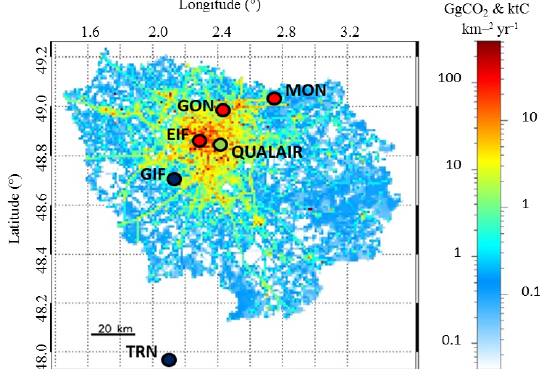
Figure 1. Annual emissions of CO 2 from Île-de-France at a spatial resolution of 1 × 1km 2 (AIRPARIF, 2010) and our Paris megacity CO 2 in situ network: the red points indicate the CO 2 -MegaParis stations (MON is a NE rural site at 9ma.g.l.; GON is a NE peri- urban site at 4ma.g.l.; EIF is an urban site at 317ma.g.l.); the dark blue points are stations from the ICOS-France network (GIF is a SW peri-urban site at 7ma.g.l.; TRN is a SW rural site at 50 and 180ma.g.l.). The QUALAIR station for monitoring the at- mospheric boundary layer height in the city of Paris is also shown (green